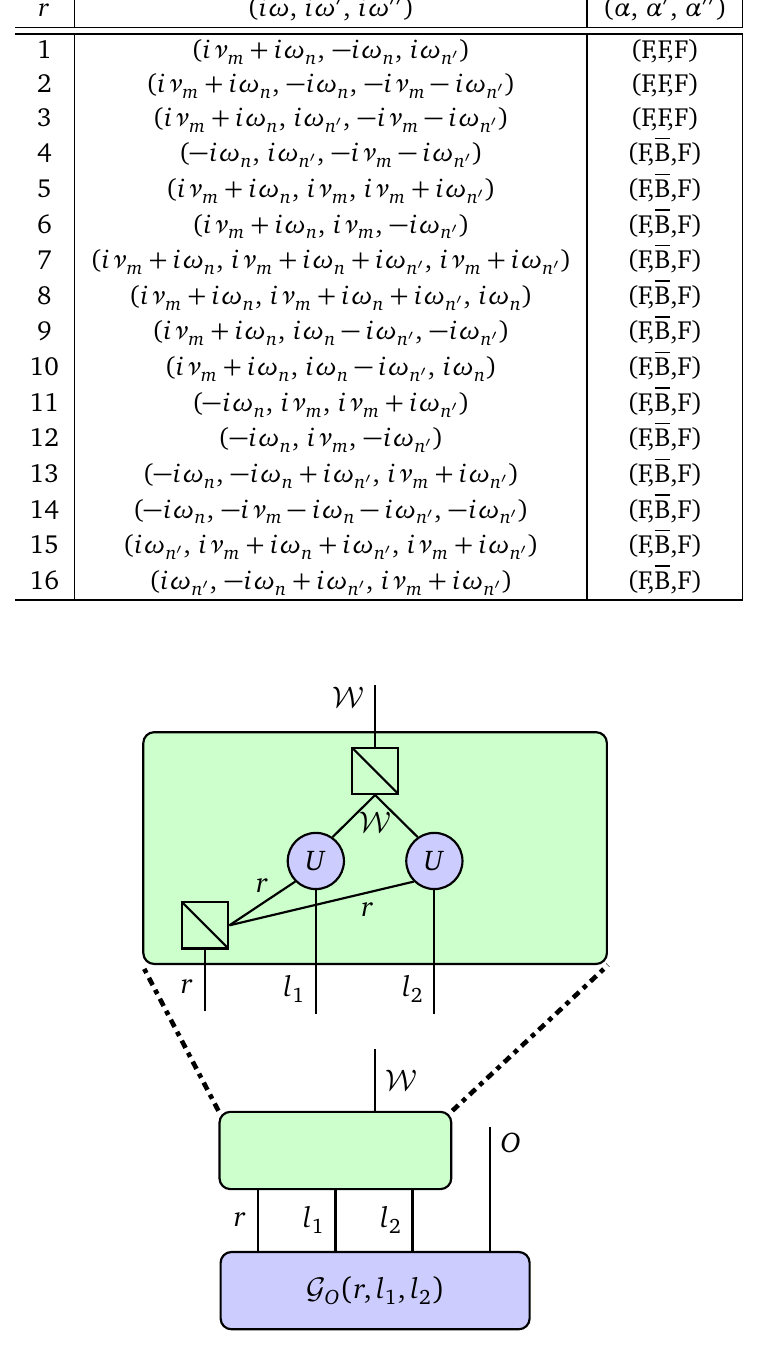
= 1 iff i = ··· = i , i 1 ··· i N N 1